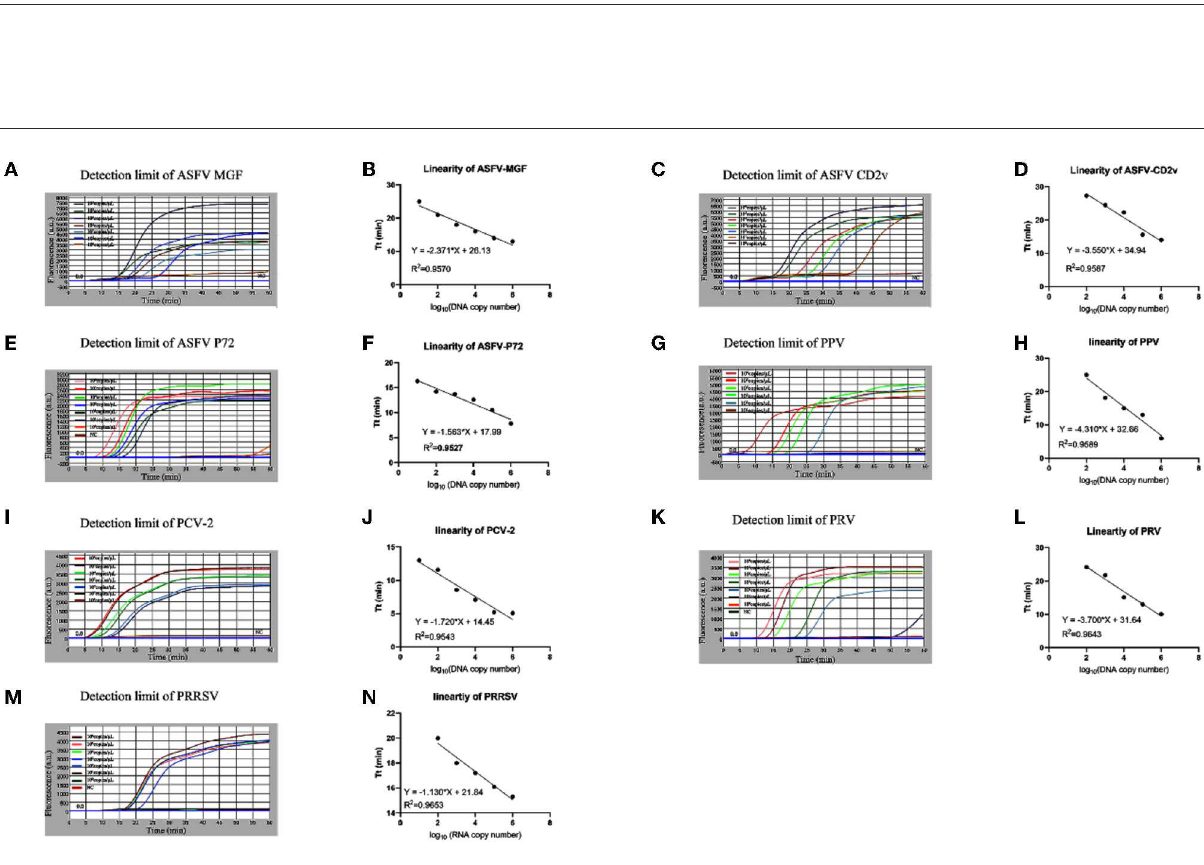
FrontiersinVeterinaryScience